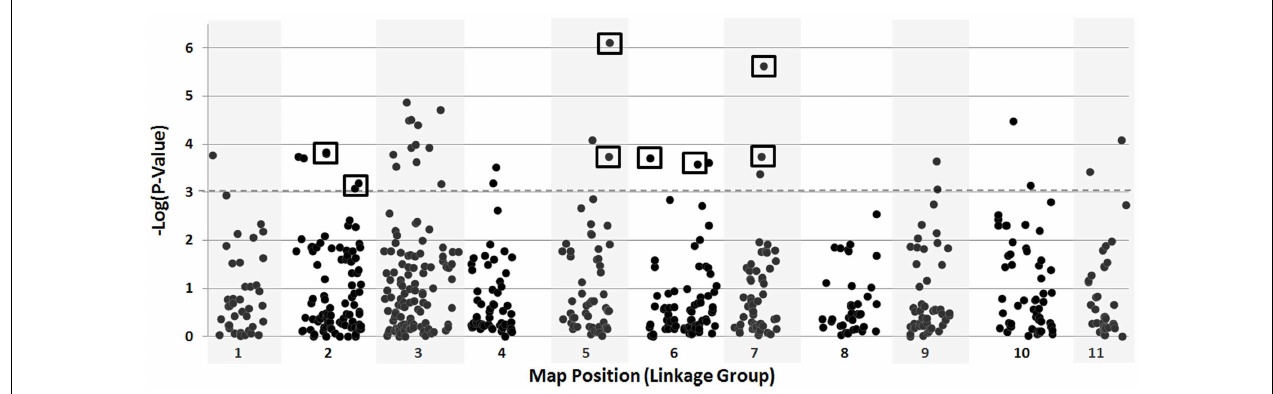
FIGURE 4 | Genome-wide association analysis of seed size using the USDA core collection of cowpea. Loci surpassing significance thresholds that were also associated with seed size among the bi-parental populations are boxed.